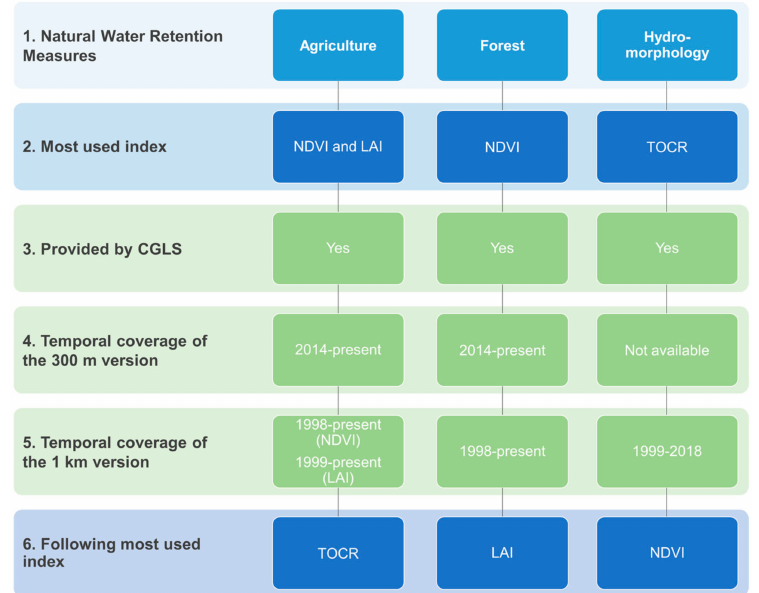
Figure 4. Decision flowchart indicating the most suitable indices available in the Copernicus Global Land Service for the monitoring of natural water retention